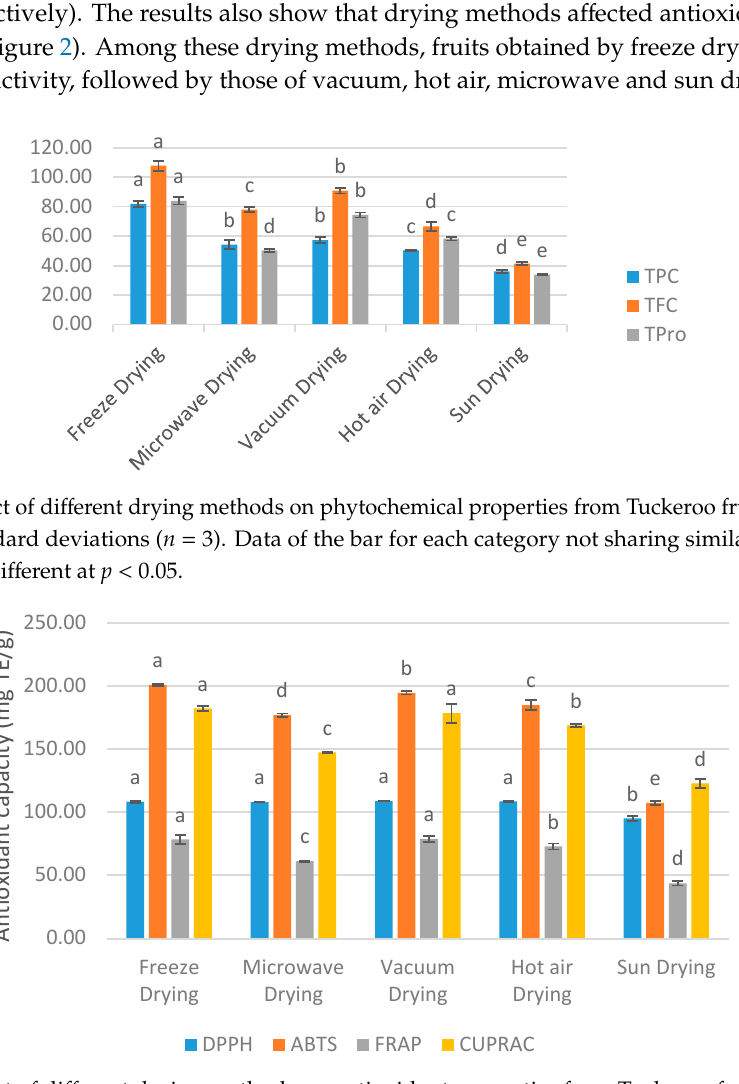
Figure 2. Effect of different drying methods on antioxidant properties from Tuckeroo fruit. Data are means ± standard deviations ( n = 3). Data of the bar for each category not sharing similar letters are significantly different at p < 0.05.